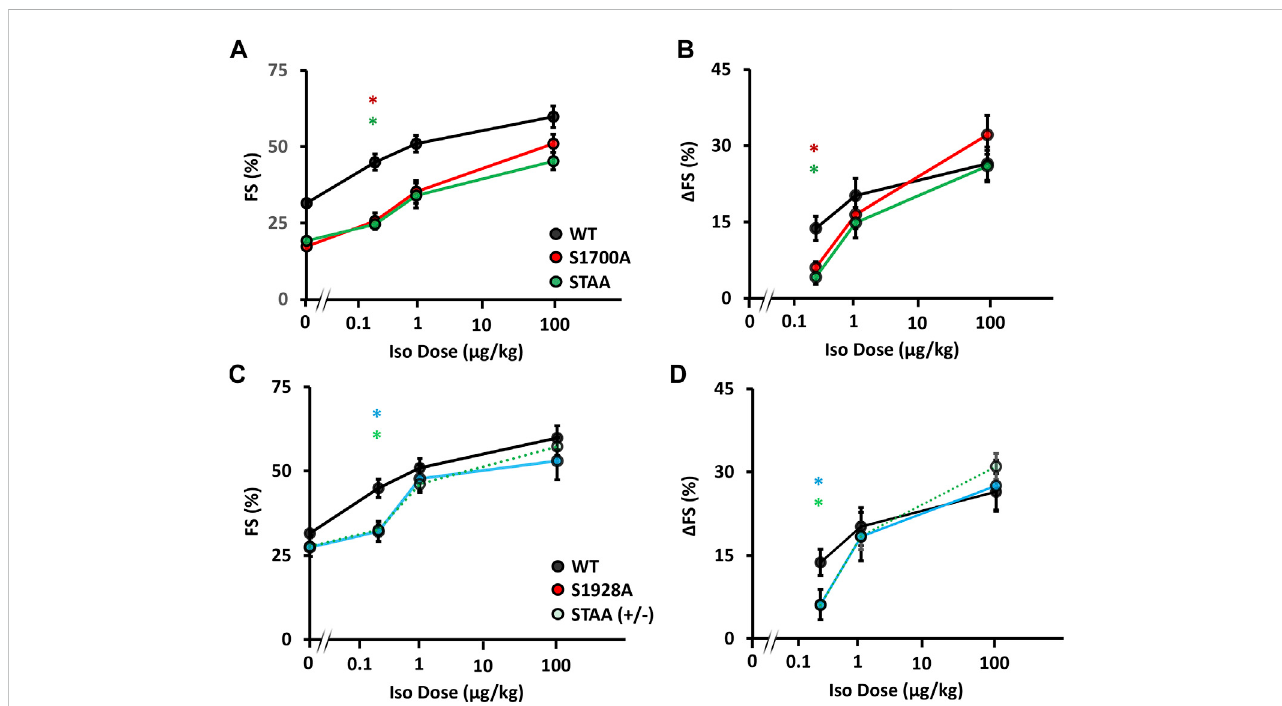
FIGURE 2 Inotropic dose-response to β -adrenergic stimulation in mice with Ca V 1.2 phosphoregulatory site mutations. Isoproterenol dose-response assessed via (A) fractional shortening, and (B) change in fractional shortening in WT, S1700A, STAA mice, and (C) fractional shortening and (D) change in fractional shortening in WT, STAA +/ − , and S1928A mice, in response to intraperitoneal drug administration. Statistical signi fi cance determined via ANOVA with Tukey post-hoc tests. Error bars are S.E.M.; N 0.25 μ g/kg = 11, 8, 6, 8, 8 (for WT, S1700A, STAA, S1928A, STAA +/ − , respectively); N 1 μ g/kg = 6, 7, 8, 6, 9 (for WT, S1700A,STAA,S1928A,STAA+/ − ,respectively);N 100 μ g/kg =7,7,7,7,11(forWT,S1700A,STAA,S1928A,STAA+/ − ,respectively);* p < 0.05(red*S1700Avs.WT, light-green STAA ± vs. WT, dark green STAA vs. WT, light-blue S1928A vs.